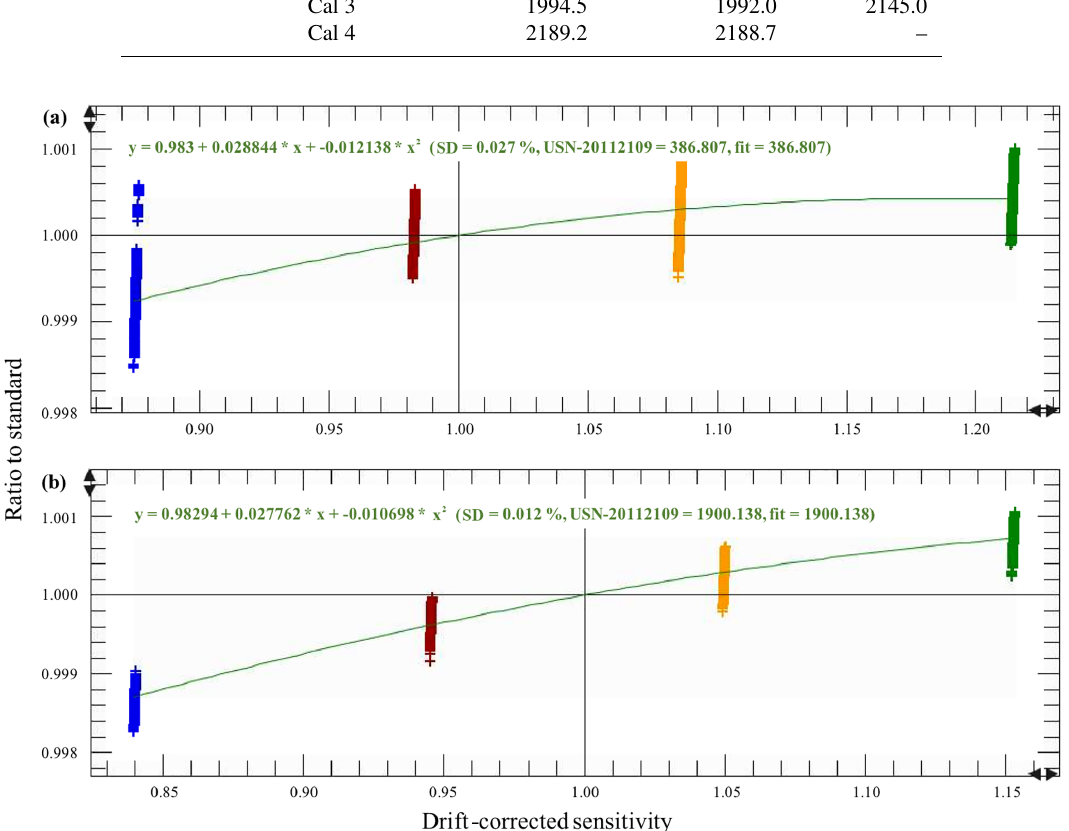
Figure 4. An example of a non-linear fit used for (a) CO 2 and (b) CH 4 at TAC from 2 April 2012 to 1 October 2015. Curve coefficients are shown within the plots, along with the standard used (USN-20112109), the assigned values and the adjusted values (fit = *values shown in the plot). Drift-corrected sensitivity is a function of the measured cylinder dry mole fraction divided by its assigned value, over the measured standard dry mole fraction divided by the assigned/adjusted standard value, as outlined in Eq.